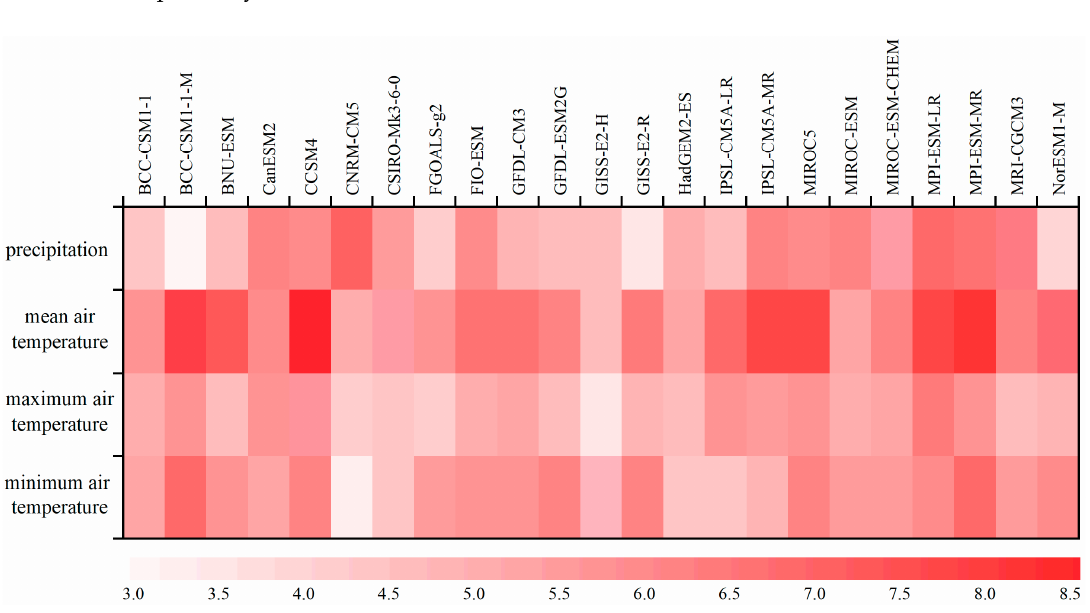
Figure 2. Performances of 23 GCMs for the precipitation, T mean, T max , and T min.